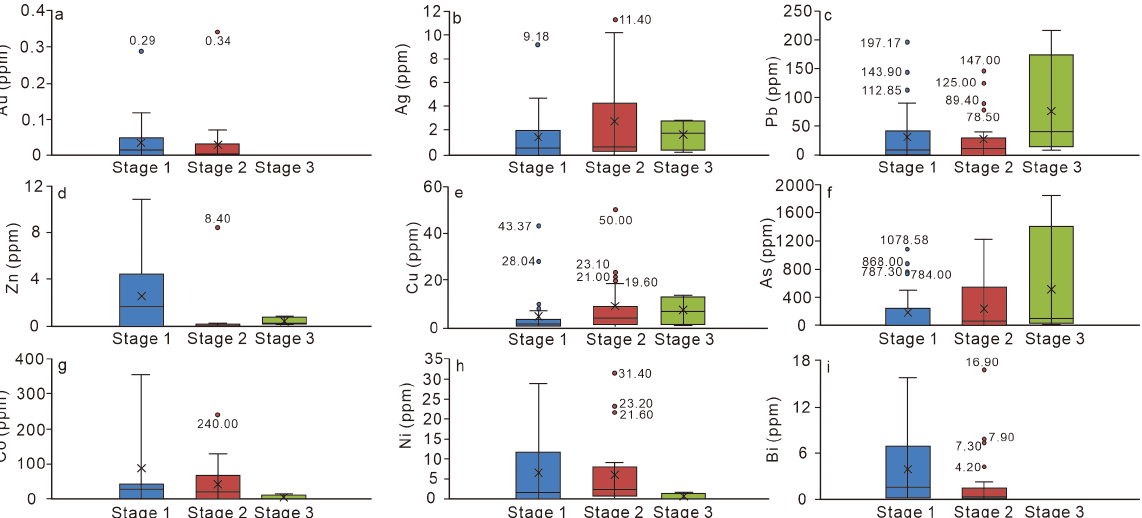
Figure 8. Box plot of LA-ICP-MS trace elemental contents of Py1 to Py3 (data listed in Table 2). ( a ). Box plot of Au contents of Py1 to Py3; ( b ). Box plot of Ag contents of Py1 to Py3; ( c ). Box plot of Pb contents of Py1 to Py3; ( d ). Box plot of Zn contents of Py1 to Py3; ( e ). Box plot of Cu contents of Py1 to Py3; ( f ). Box plot of As contents of Py1 to Py3; ( g ). Box plot of Co contents of Py1 to Py3; ( h ). Box plot of Ni contents of Py1 to Py3; ( i ). Box plot of Bi contents of Py1 to Py3.